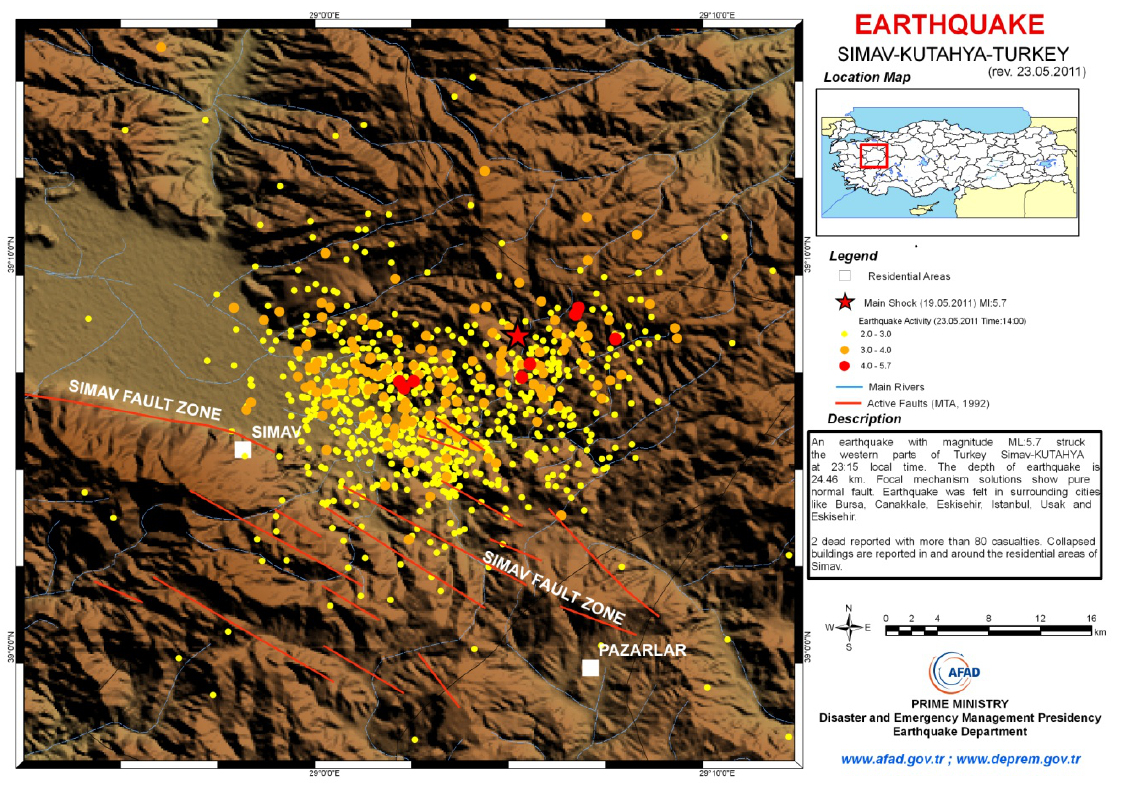
Figure 2. Locations of Simav earthquake aftershocks